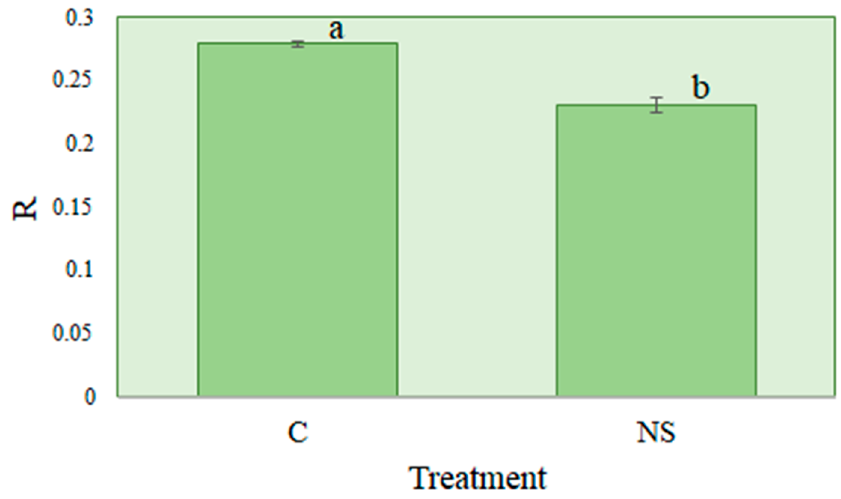
Figure 5. Nitrogen stress index (R) assessment using a smartphone. Strawberry plants were exposed to nitrogen stress (NS) and optimal (C) treatments. Letters ‘a’ and ‘b’ indicate that the means are statistically different. Error bars represent standard error of the mean.